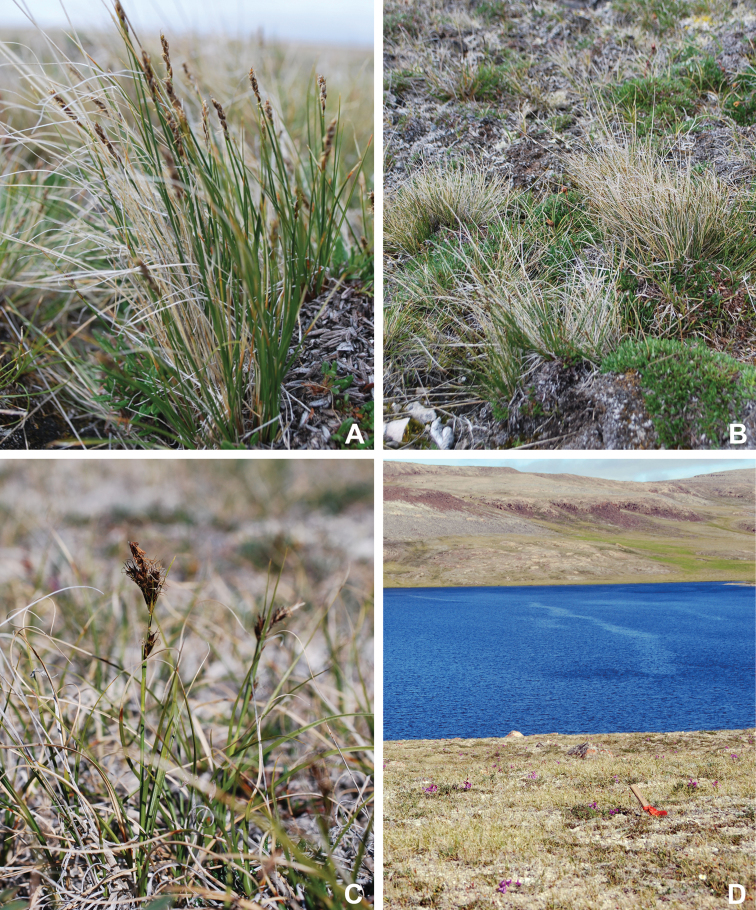
ACarex
myosuroides habit BCarex
myosuroides habitat CCarex
petricosa
subsp.
petricosa habit, Gillespie et al. 9657DCarex
petricosa
subsp.
petricosa habitat, Gillespie et al. 9657. Photos A, B by B.A. Bennett and C, D by J.M. Saarela.